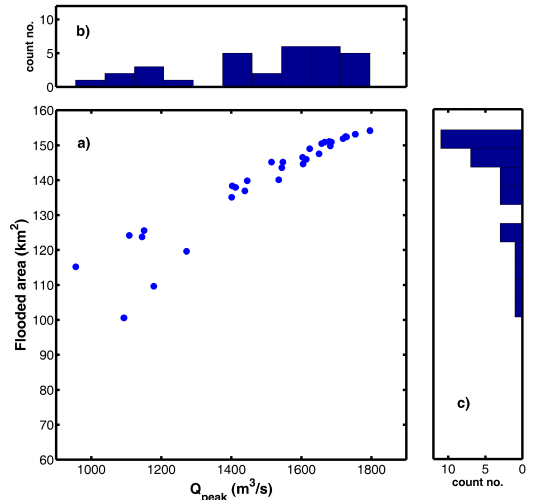
Figure 9. (a) Maximum-flooded area vs. peak discharge estimated for all 31 hydrodynamic simulations of the 2009 flood event; (b) histogram of peak discharges; (c) histogram of estimated size of the maximum-flooded